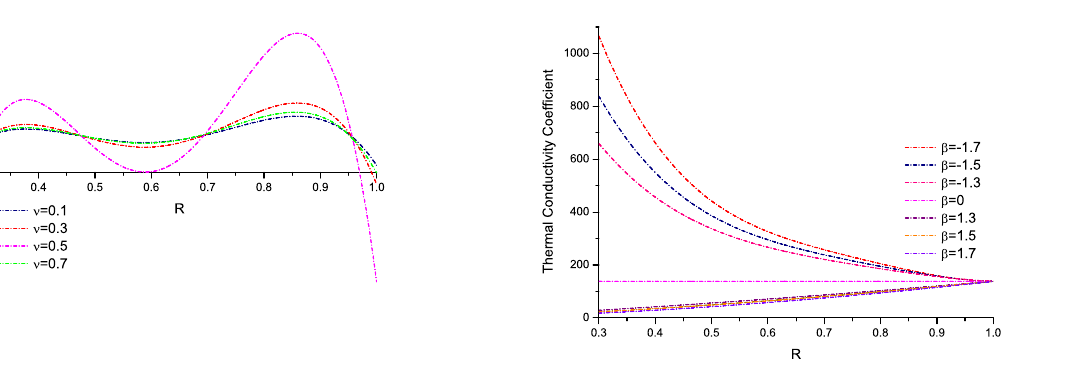
Figure 13: Distribution of thermal conductivity coefficient along radial direction for different values of β .